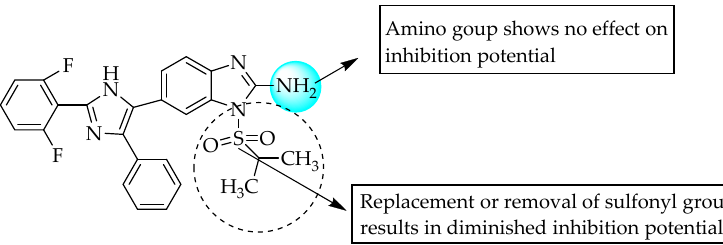
Figure 16. SARs of 2-amino-1-isopropylsulfonyl 6-substituted benzimidazole. In 2005, Dios et al. studied the importance of the N -sulfonyl group incorporated 2-aminobenzimidazole as a p38 α MAP kinase inhibitor. The compound with a piprid-4-yl at R 3 showed the highest efficacy and selectivity. A 2,4-difluoro substitution at R 2 led to better inhibition than mono-fluoro substitution; moreover, optimum steric bulky groups with three carbons at R 1 favoured p38 α MAP kinase inhibition [27]. How- ever, bulkier groups at R 1 led to a reduction in the inhibition of p38 α MAP kinase activity. The SAR of the compounds is shown in Figure 17. Figure 17. SARs of sulfonyl group incorporated 2-aminobenzimidazoles.